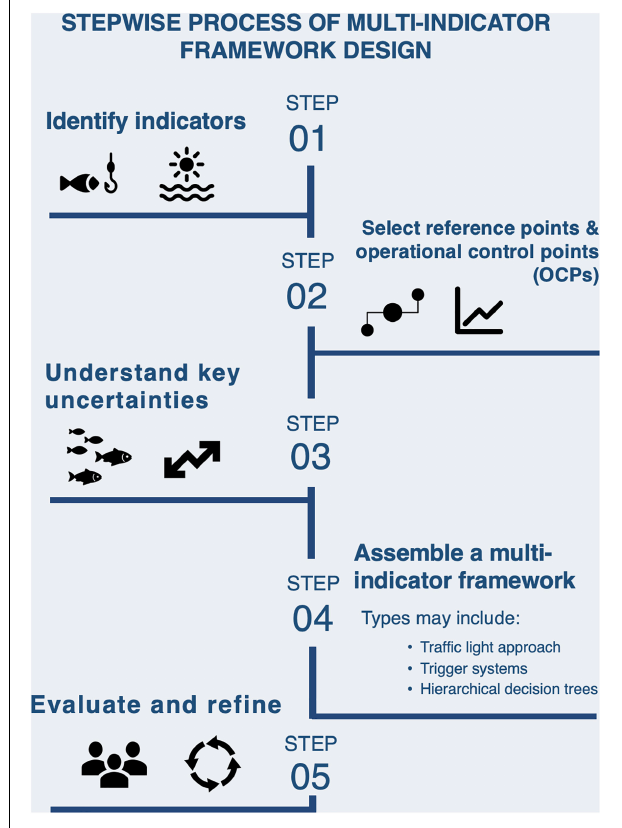
FIGURE 1 | Stepwise process of multi-indicator framework